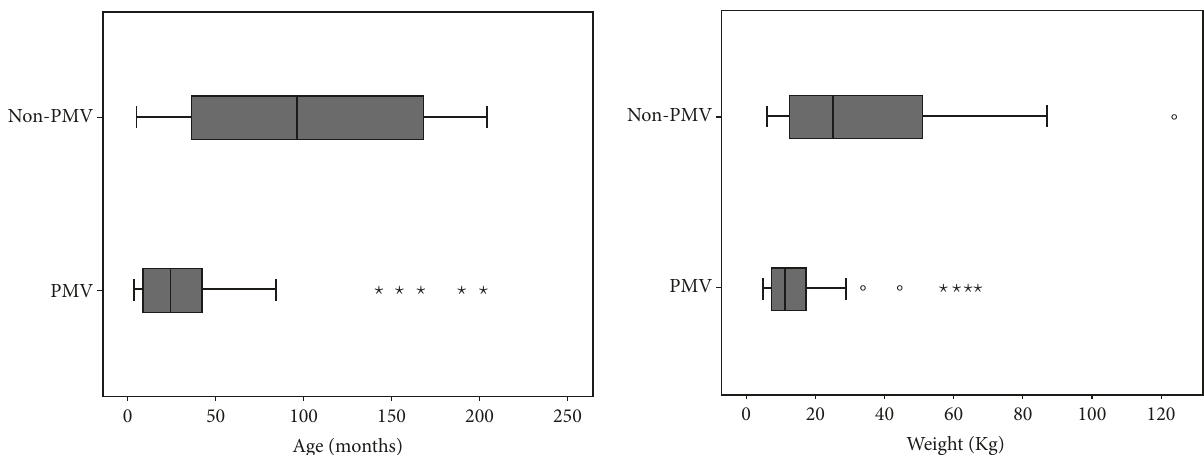
Figure 1: Box plots showing the distribution of age (months) and weight (Kg) stratified by postoperative ventilation status among 128 pediatric liver transplant recipients. Expectedly age and weight data were skewed. Children requiring prolonged postoperative ventilation were significantly younger ( 𝑝 = 0.001 ) and weighed less ( 𝑝 = 0.005 ) than those who were extubated early. PMV: prolonged mechanical ventilation. Circles and stars refer to outliers or extreme values.